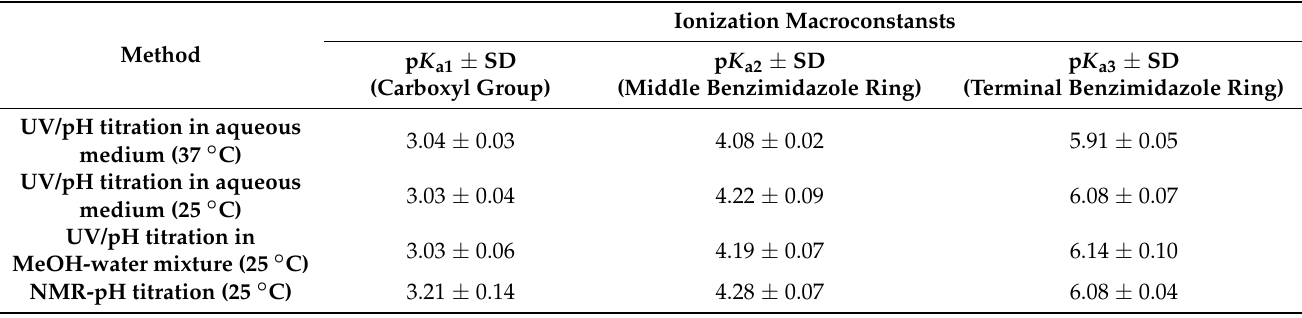
Table 1. Ionization macroconstants of Telmisartan measured by different